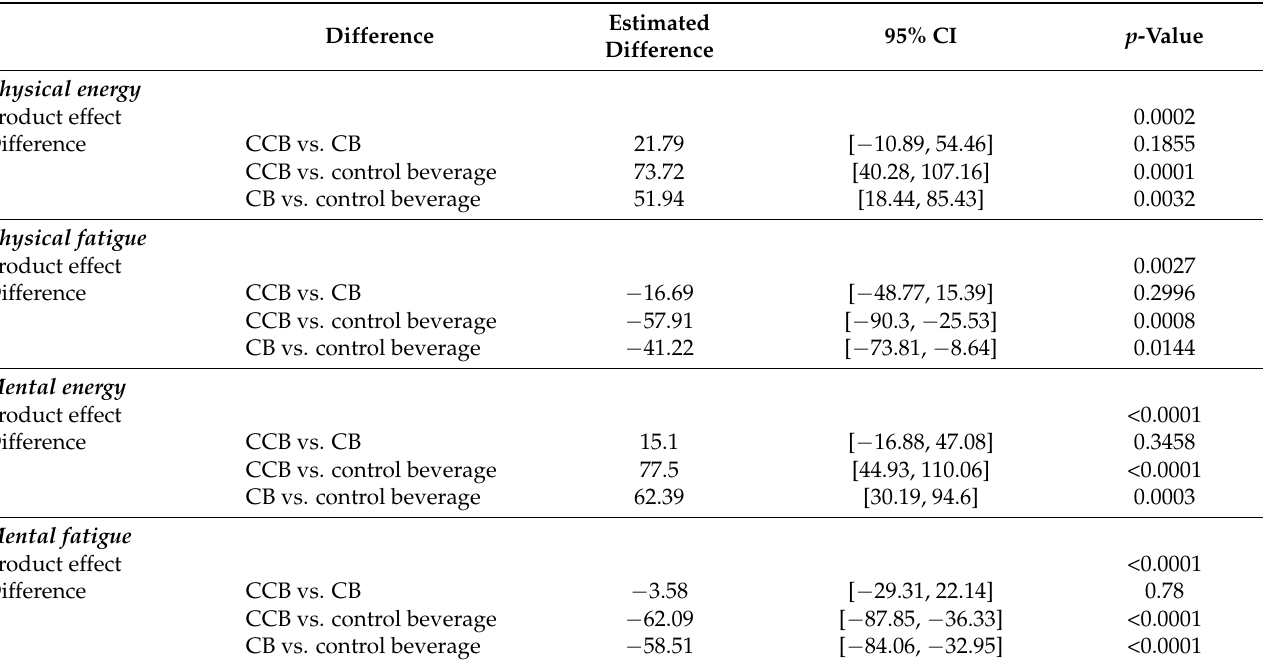
Table 2. Product comparisons for self-reported Physical energy, Physical fatigue, Mental energy, Mental